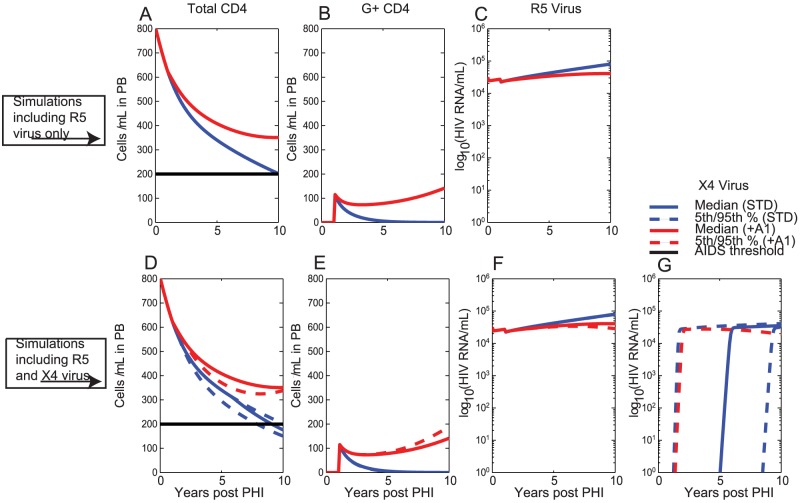
One-off delivery of gene therapy to CD4+T cells assuming that 20% of CD4+T cells receive the gene construct at year 1.Therapy is administered at year 1. Shown are the simulation outcomes under the standard scenario (STD) and under Assumption +A1 of reduced bystander apoptosis in G+ CD4+T cells (+A1); Solid lines denote median values, dashed lines denote the 5th and 95th percentile ranges for outcomes when ×4 virus can develop. Also shown is the AIDS threshold of 200 cells/ µL (solid horizontal black line); A) Total CD4+T cell count, B) G+ CD4+T cell count and C) R5 Viral Load for a single simulation with R5 virus only (i.e. assuming  throughout the course of infection); D) Total CD4+T cell count, E) G+ CD4+T cell count F) R5 Viral Load and G) ×4 Viral Load for Monte Carlo simulations assuming initial infection with R5 virus, but now including ×4 virus. Monte Carlo simulations were performed for 100 trials and involved repeated sampling of parameter  from a uniform distribution (see Methods and Table S1).